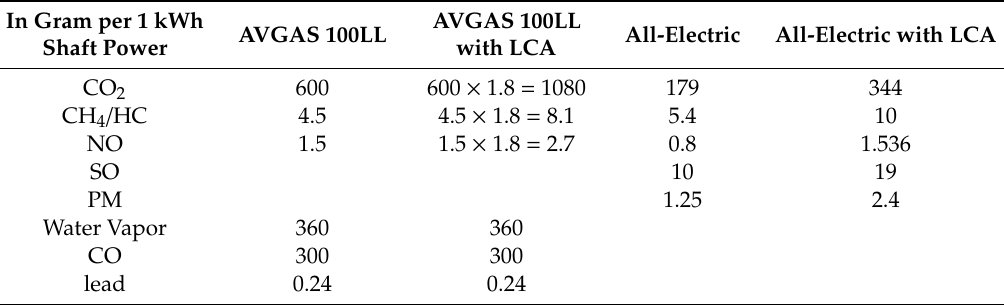
Table 3. Emission